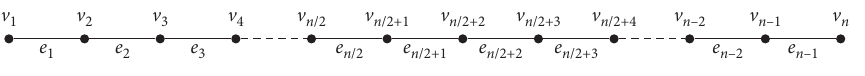
. (b) A strong 2-edge even graceful labeling for K 4